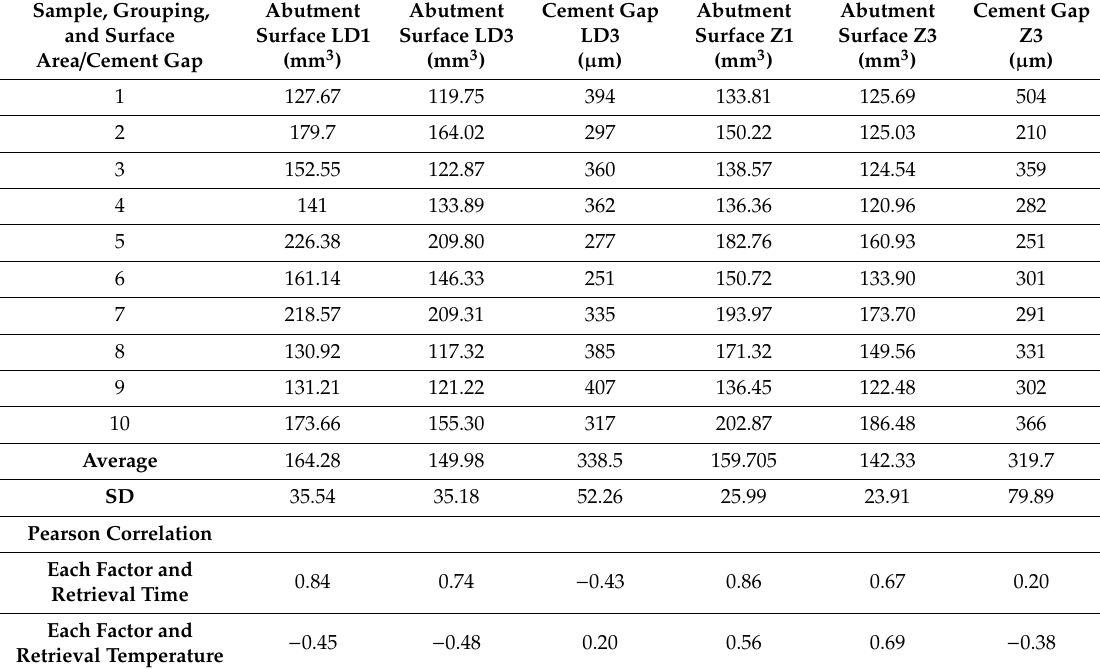
Table 3. E ff ects of tooth modification on retrieval times and